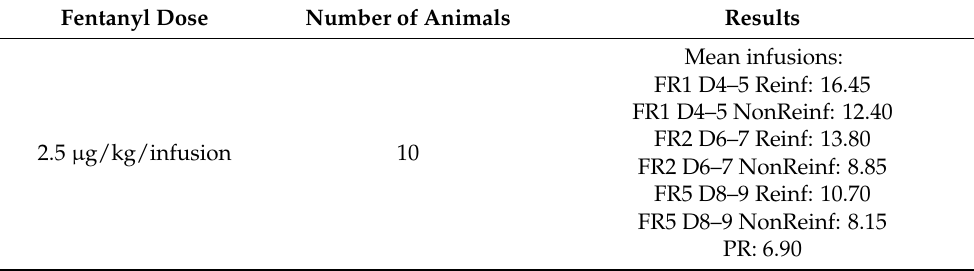
Table 1. Cont. Fentanyl Dose Number of